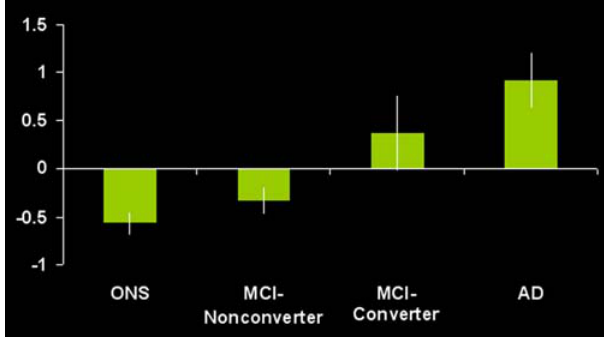
Figure 3. Bar graph demonstrates activation magnitude parameter estimate in the PMC region (taken from Figure 1), demonstrating a continuum from control, to MCI-Nonconverter, to MCI-Converter, to AD. There were statistically significant (p , 0.05) differences between all groups with the exception of the control and MCI-Nonconverter group, and the AD and MCI-Converter group. Note the overall pattern of negative activation magnitude in the Control and MCI-Nonconverter groups, and positive activation magnitude in the AD and MCI-Converter groups.